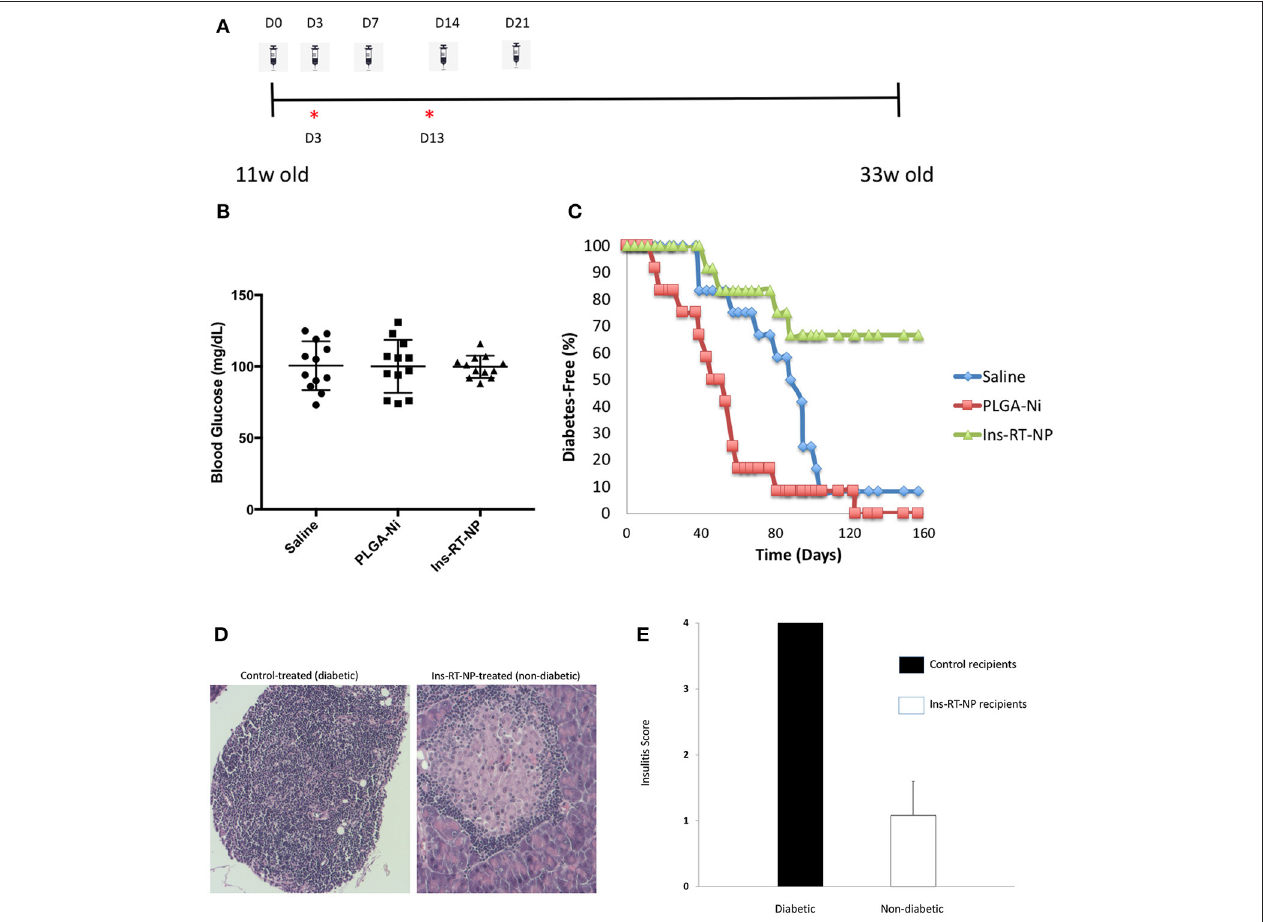
FIGURE 4 | Prevention of diabetes onset following Ins-RT-NP administration. Non-diabetic female NOD mice at 11 weeks of age were randomly assigned to three treatment groups ( n = 12 per group). Each mouse received five subcutaneous abdominal injections of saline vehicle, 10mg of PLGA-Ni in solution, or 10mg of Ins-RT-NP in solution as shown in the dosing schedule timeline (A) . The timeline also shows the tissue harvest time points (“*”) from an additional cohort of animals (“ acute study cohort ”; Figure 5 ). (B) No significant difference was observed in the starting blood glucose values (prior to microparticle injection; p = 0.981, Kruskal-Wallis test). (C) Mice were assessed for diabetes status by measuring tail vein blood glucose, where two consecutive readings over 300 mg/dL indicated diabetes onset. Shown in the graph are the survival curves representing diabetes-free mice. Diabetes incidence in Ins-RT-NP-treated mice was significantly lower when compared to saline ( p = 0.0119) and PLGA-Ni ( p = 0.0001) treatment. A log-rank test (Mantel-Cox) confirms significance in the differences among the treatment groups ( p < 0.0167; p < 0.05 Bonferonni-corrected for three groups). (D) Insulitis grade was significantly-lower in pancreas sections of 33 week-old diabetes-free RT-NP recipients compared to all the diabetic mice in the control arms. Shown are images at 10X magnification representative of > 5 islets/field visualized per treatment arm. (E) Summary of insulitis scores between all diabetic mice and the Ins-RT-NP recipients who were diabetes-free at 33 weeks of